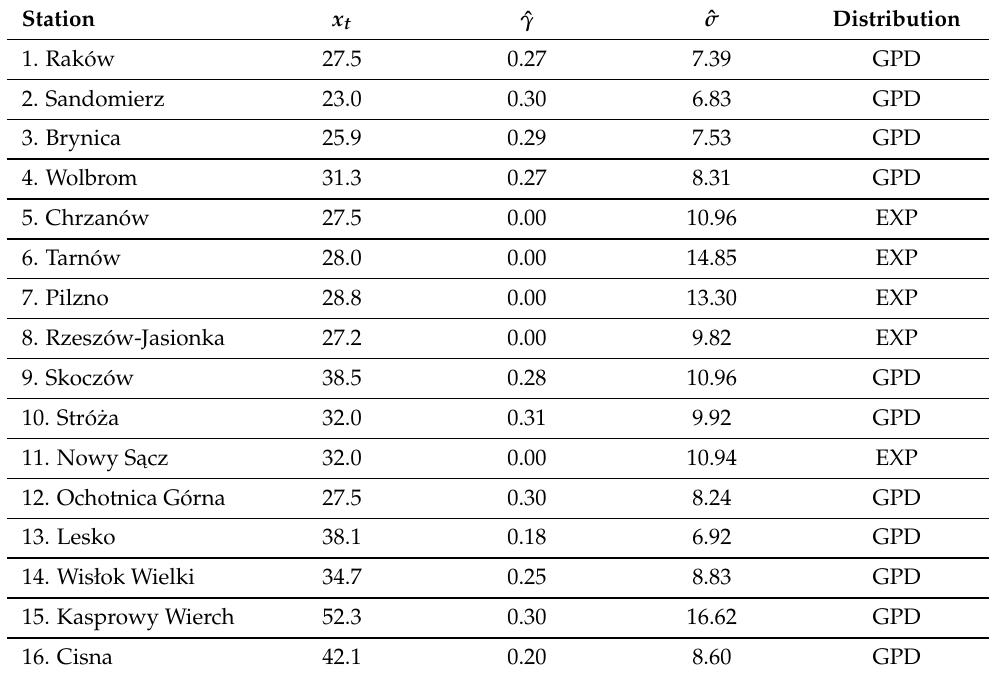
Table 2. The values of the x t , ˆ γ , and ˆ σ parameters for each station. Station